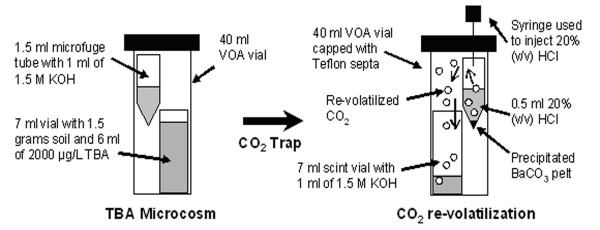
Experimental microcosm and CO2 re-volatilization setups.